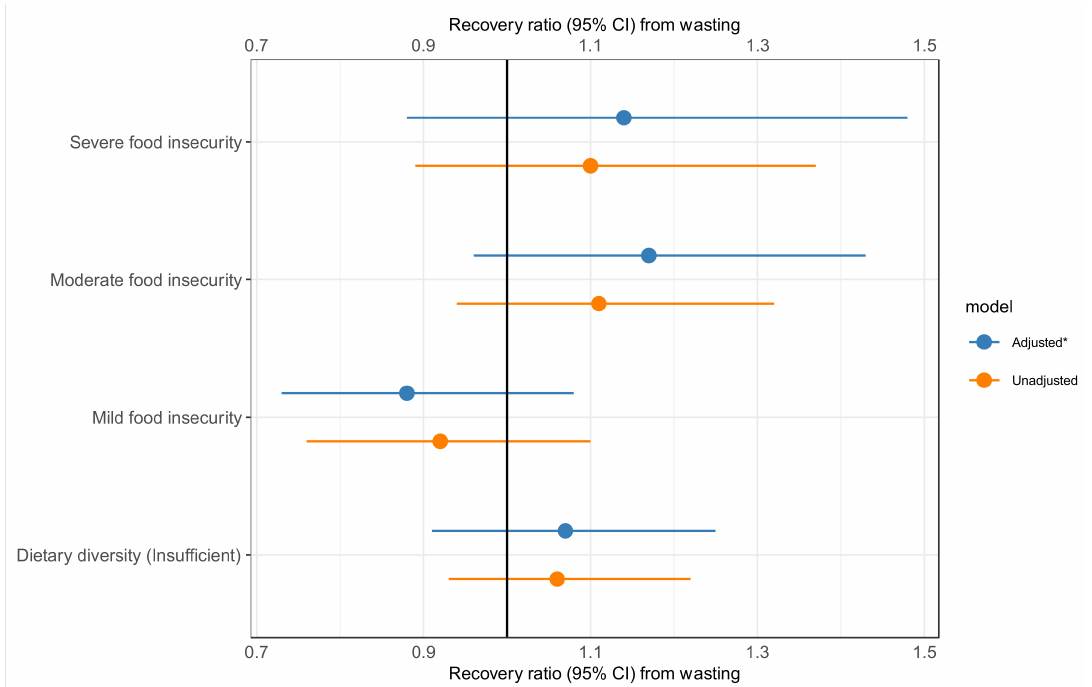
Figure 5. Association of food insecurity and dietary diversity with recovery from wasting. *Adjusted for child age, child sex, child HIV status, child baseline nutritional status, discharge to